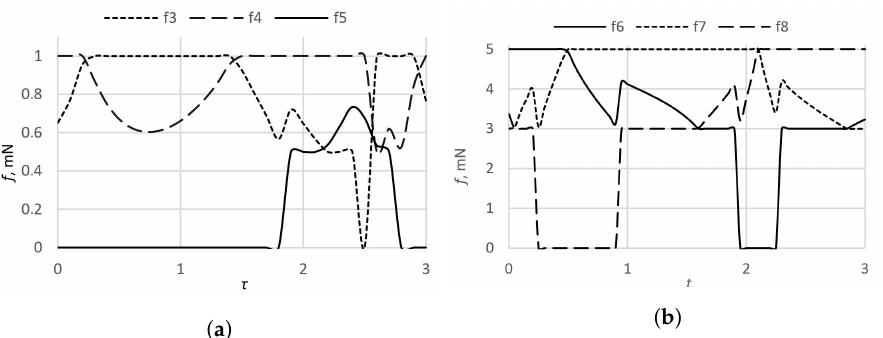
Figure 12. Forces of electrode segments: ( a ) the sphere; ( b ) the